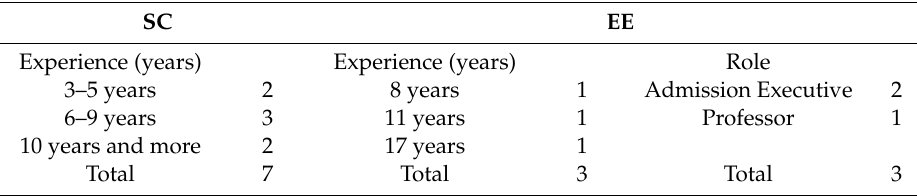
Table 1. Profile of the